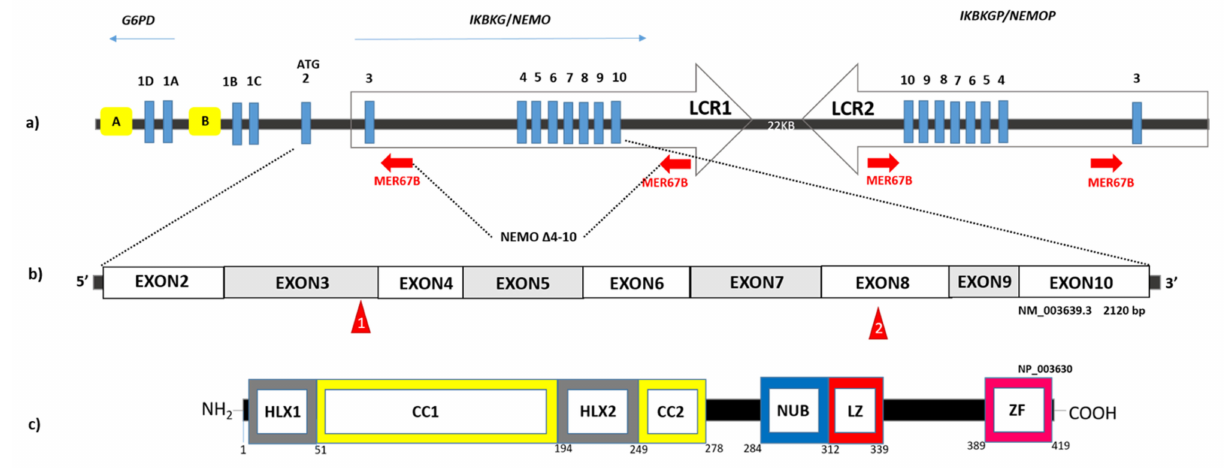
Figure 2. The NEMO/IKBKG locus. ( a ) Schematic representation of the genomic organization of the NEMO/IKBKG gene and pseudogene ( IKBKGP ) in Xq28 region and the pathogenic IKBKGdel ( NEMO ∆ 4-10 ) deletion produced by recombination between MER67B repeats (red arrows). The gene is part of a 35.7 kb segmental duplication (Kilobase) containing two LCRs (Low Copy Repeats) regions shown as two opposite arrows: 1 and 2 (LCR1 chrX: 153784097-153819590; LCR2 chX: 153841350- 153877149, UCSC 2013). The IKBKG gene is composed of nine coding exons (blue rectangles) and four non-coding alternative exons (1D, 1A, 1B, 1C). Transcription is directed by the bidirectional promoter B or by the unidirectional promoter A (yellow boxes), located in intron 2 of the G6PD gene. ( b ) Schematic view of the transcription of IKBKG gene and of the small mutations found in the IP male are shown in the red triangles (p.Gln132* and p.Gln313*) [26,42]. ( c ) Schematic view of the NEMO/IKK γ protein and its structural domains from the N-terminal to the C-terminal: HLX1, Helical domain (aa: 1-51); CC1, Coiled Coil (aa: 52-194); HLX2, Helical domain (aa: 195-249); CC2, Coiled Coil (aa: 250-278); NUB, NEMO Ubiquitin Binding (aa: 284-312); LZ, Leucin Zipper (aa: 312-339); ZF, Zinc Finger (aa: